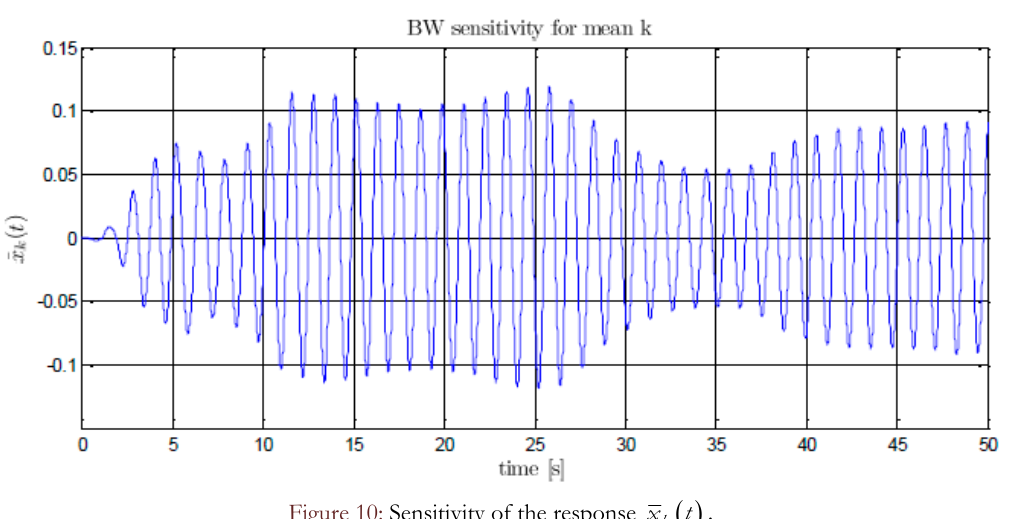
Figure 10: Sensitivity of the response  